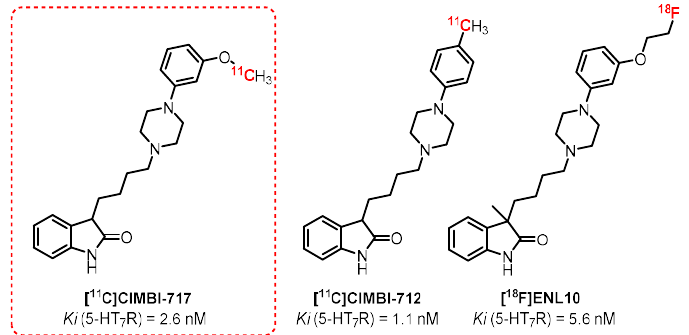
Figure 18. [ 11 C]CIMBI-717 , [ 11 C]CIMBI-712 , and [ 18 F]ENL10